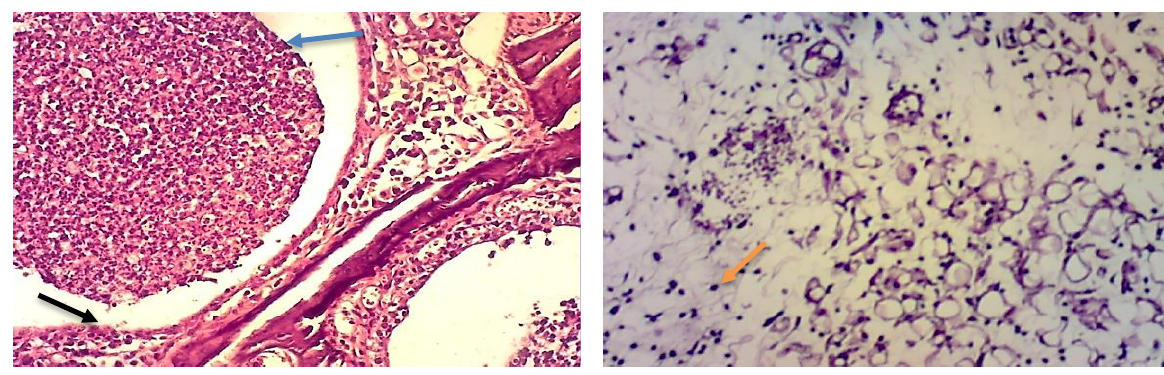
Figure, 4: Histological section show odema and neutrophil infiltration in sub epithelial layer of external ear. H &E stain 40X.